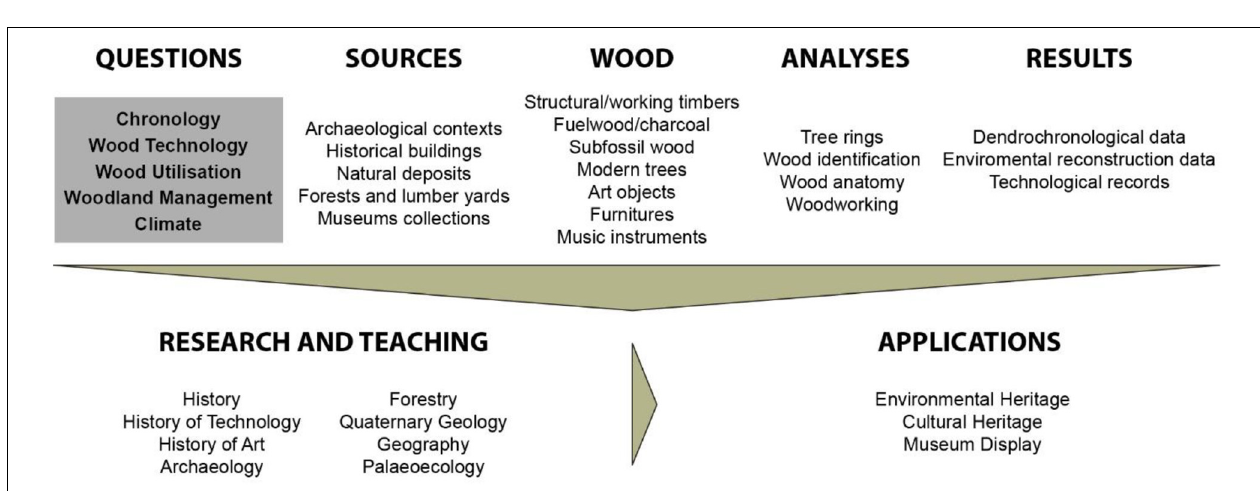
FIGURE 11 | Tree-ring anomalies. (A) Cockchafer outbreak pattern on a recent oak from Diesenhofen, Switzerland, with cyclic growth reductions every three years combined with higher early wood production. (B) Two years reduction in tree-ring width (red arrows) by pollarding of oak ( Quercus cerris , Albania). (C) Stem disk from an oak standard (Welbhausen, Germany) with periodical growth release pattern induced by coppice-with-standard forest management practice.